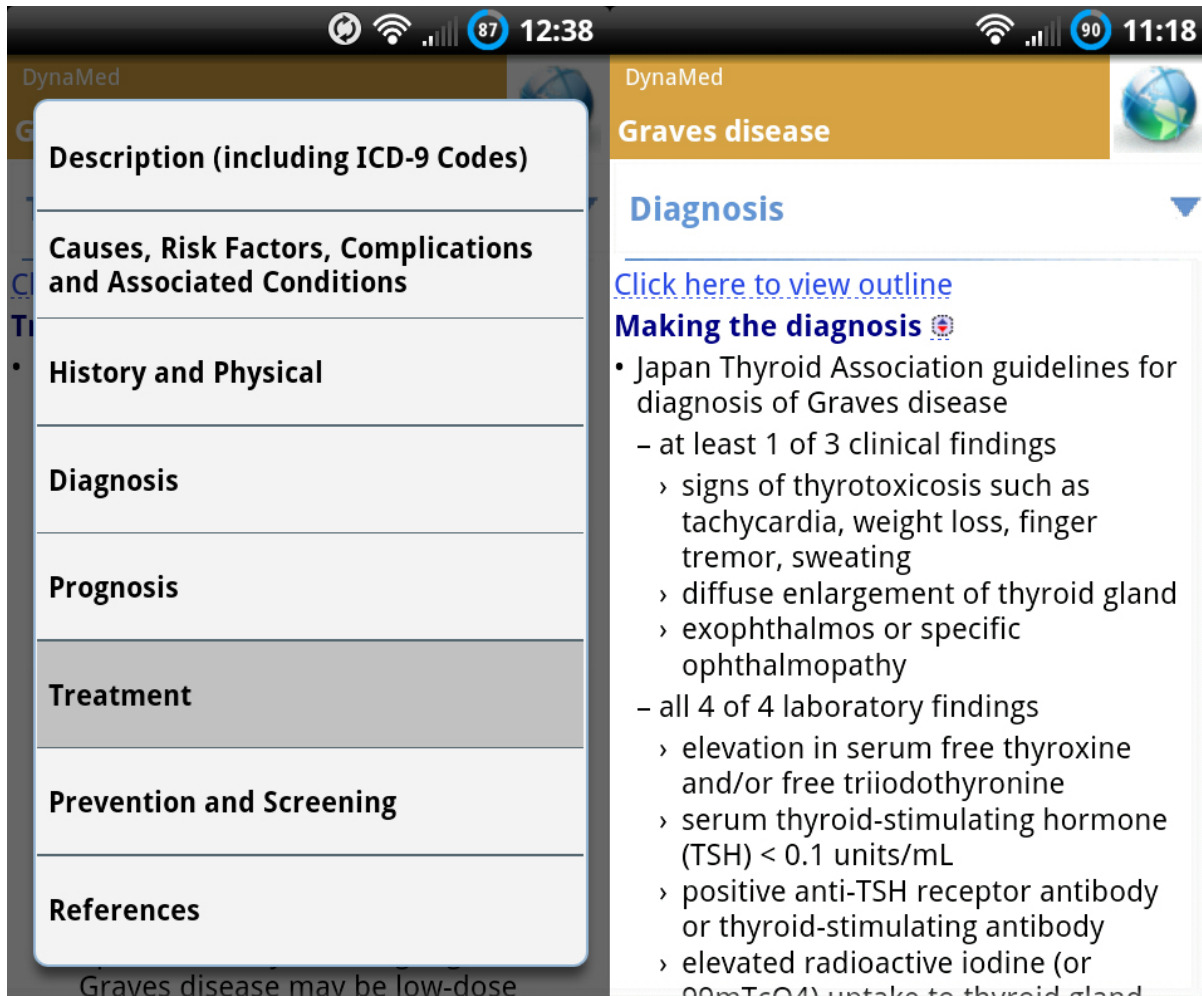
Figure 2. DynaMed’s medical reference program with organization of topics shown at